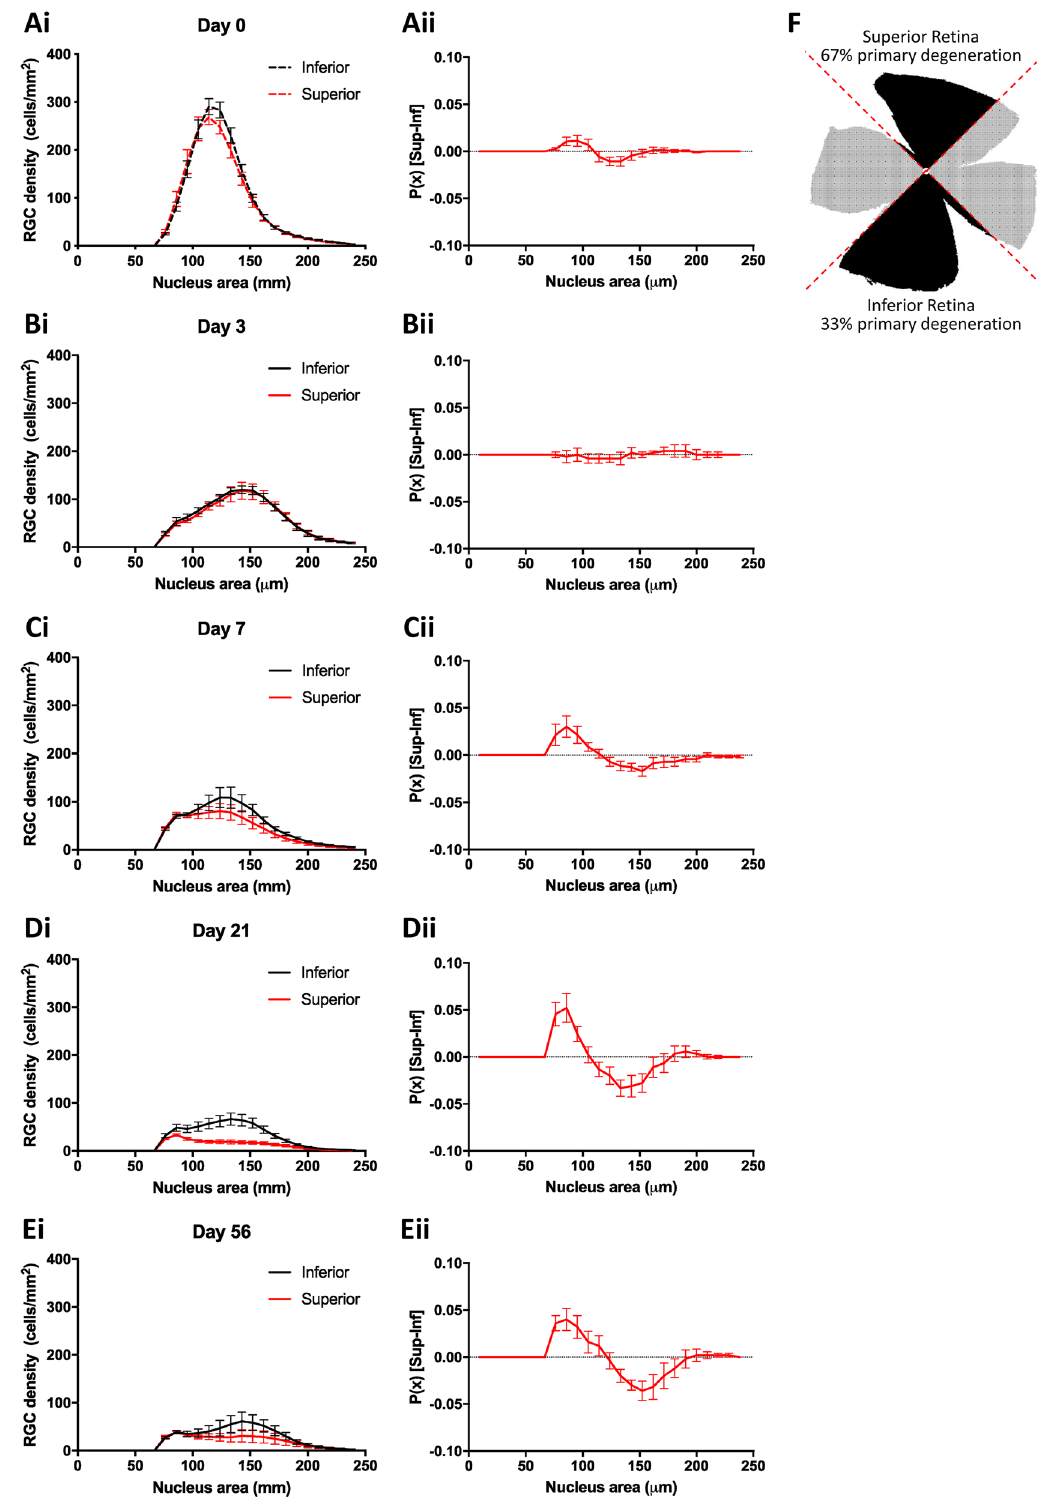
Figure 4. The size dependence of RGC loss in the pONT model is related to susceptibility to primary and secondary neurodegeneration. ( Ai – Ei ) PDF of RGC soma area from paired superior vs inferior retinal quadrants at each timepoint. ( Aii – Eii ) Difference between superior and interior PDFs from ( Ai – Ei ). At first, retinal neurodegeneration is comparable in both superior and inferior retinal quadrant regions. As the model progresses, however, a greater proportion of smaller RGCs are observed in the superior than inferior retina, suggestive that RGCs becoming smaller precedes primary degeneration or that larger RGCs are more susceptible to secondary degeneration. No such trend was observed in the OHT model (data not shown), most likely due to the milder, more chronic nature of this model. ( F ) Schematic representation of retinal regions more prone to primary vs secondary neurodegeneration in the pONT